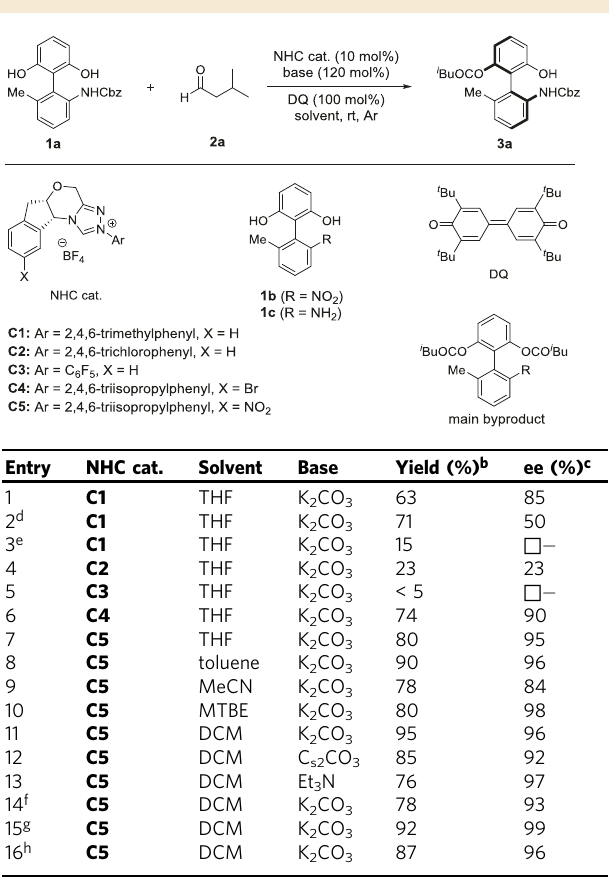
Table 1 Optimization of the reaction conditions a